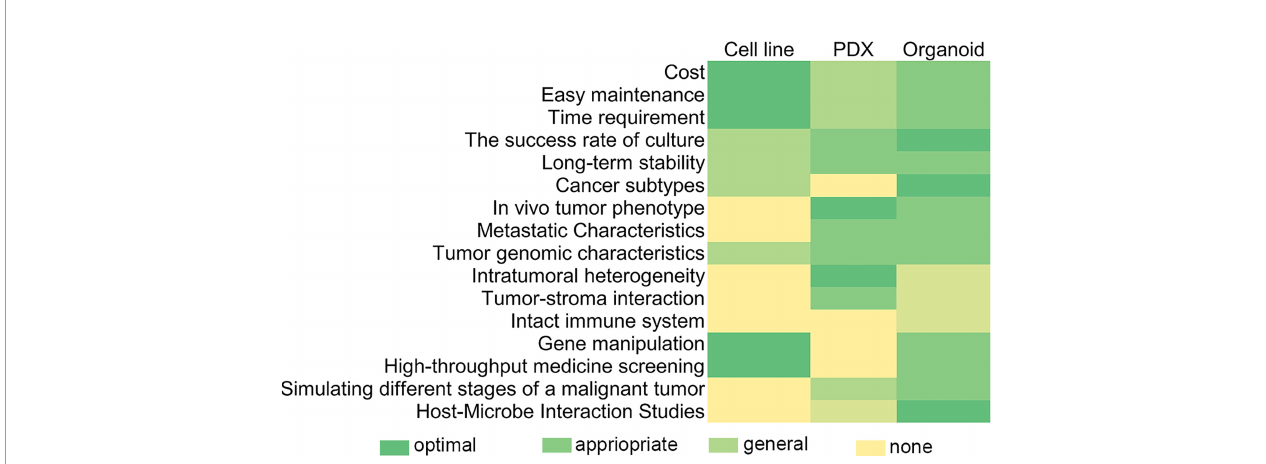
FIGURE 1 | Comparison and evaluation of organoid with traditional tumor research models in the feasibility of cultivation conditions and range of clinical and genetic